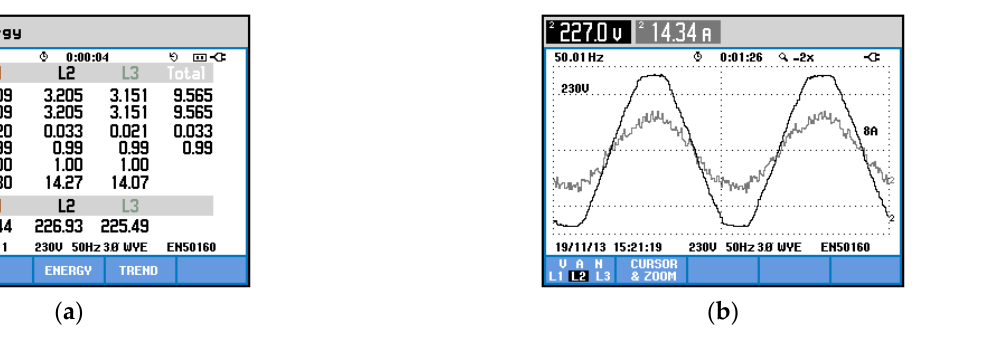
Figure 31. Case 2 - ZSS and three-wire ShAPF operating with balanced loads: ( a ) source power; ( b ) Figure 31. Case 2—ZSS and three-wire ShAPF operating with balanced loads: ( a ) source power; voltage and current waveforms in phase S. ( b ) voltage and current waveforms in phase S. .